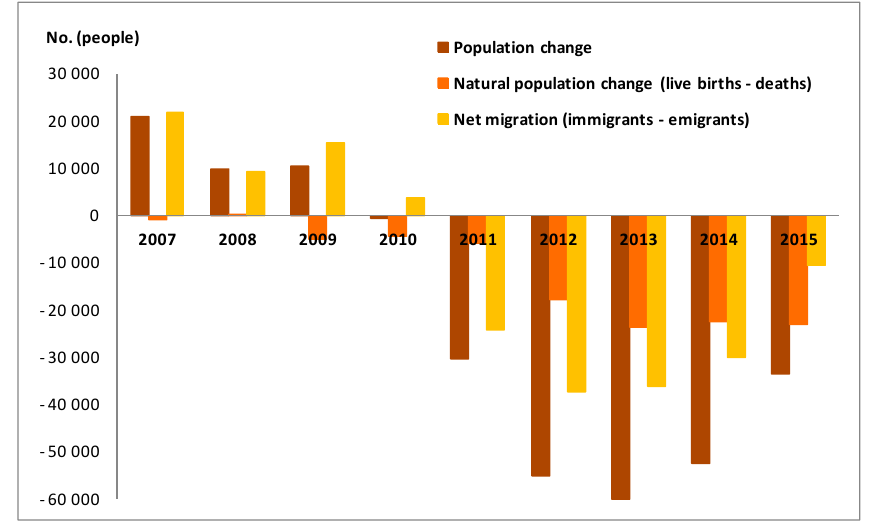
Figure 6. Portuguese demographic evolution 2007-2015 (Data source: Statistics Portugal).